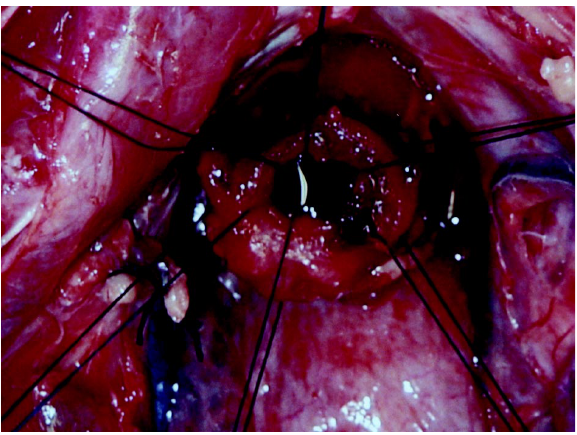
Figure 9 – All stitches passed in the urethral